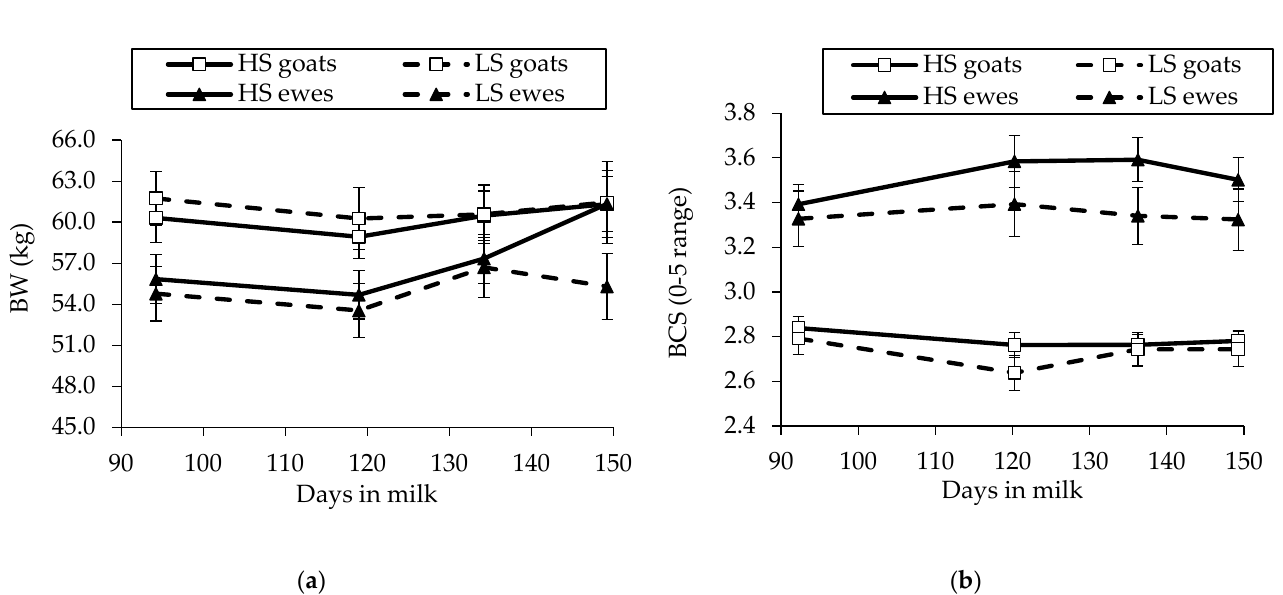
Figure 3. Evolution of ( a ) body weight (BW; kg) and ( b ) body condition score (BCS; 0–5 range) in mid-lactating Saanen goats and Sarda ewes fed high-starch (HS) and low-starch (LS) diets. The vertical lines at each symbol indicate the SEM of the values.